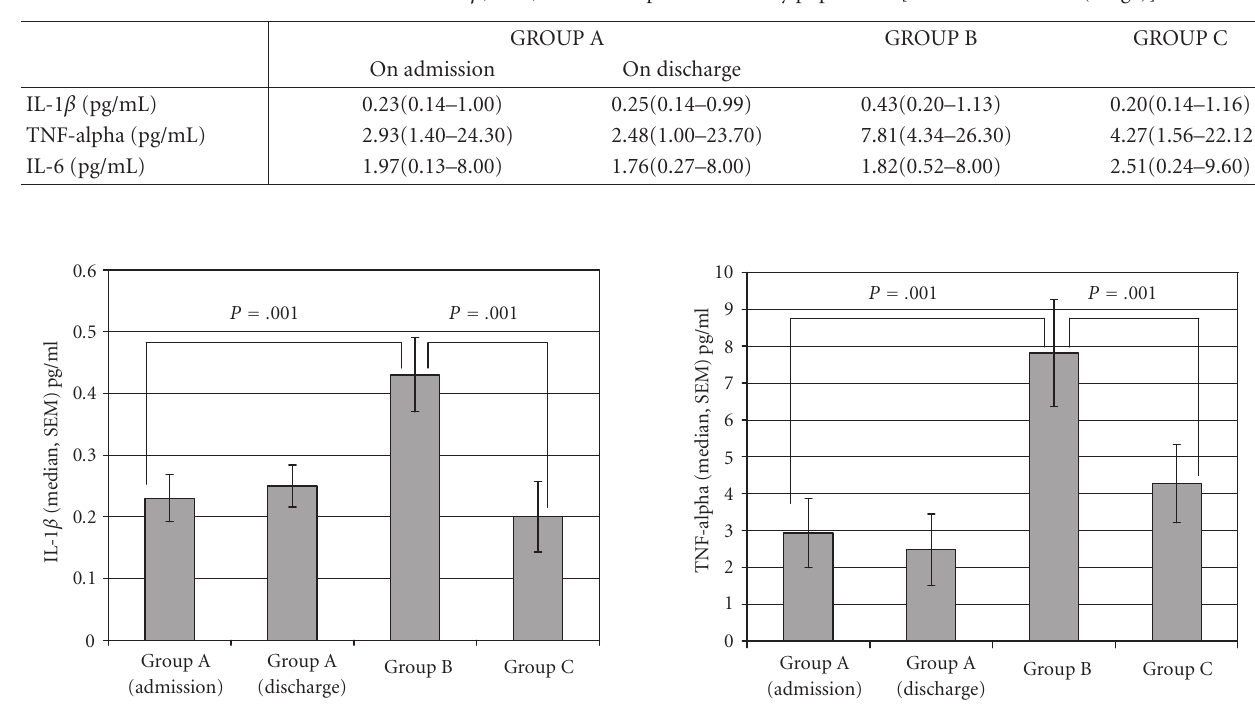
Table 1: Maternal serum levels of IL-1 β , IL-6, and TNF-alpha in the study population [values are medians (range)].